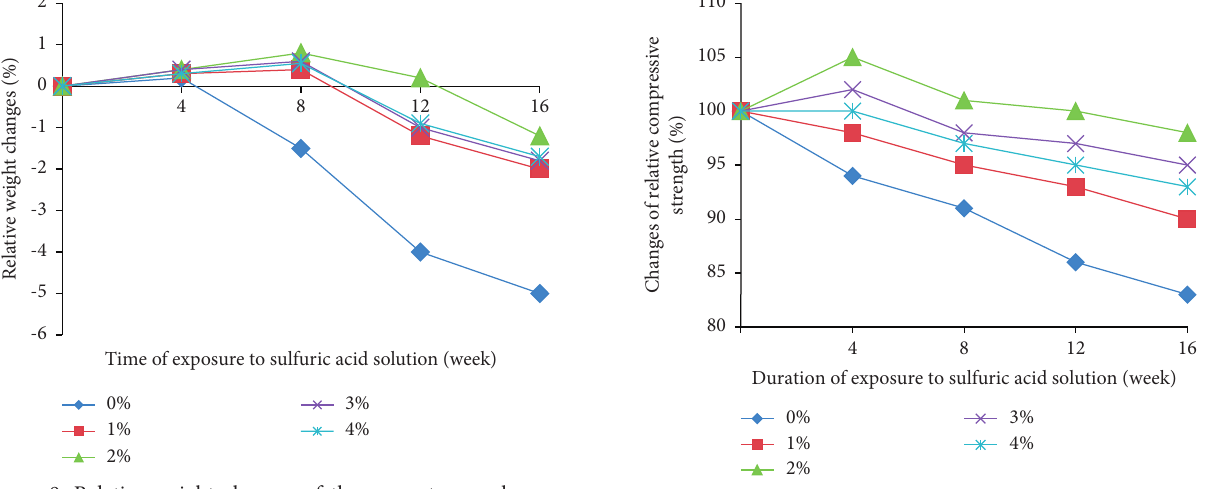
Figure 12: Changes in relative compressive strength of the con- crete samples containing GO/Al 2 O 3 particles in sulfuric acid.